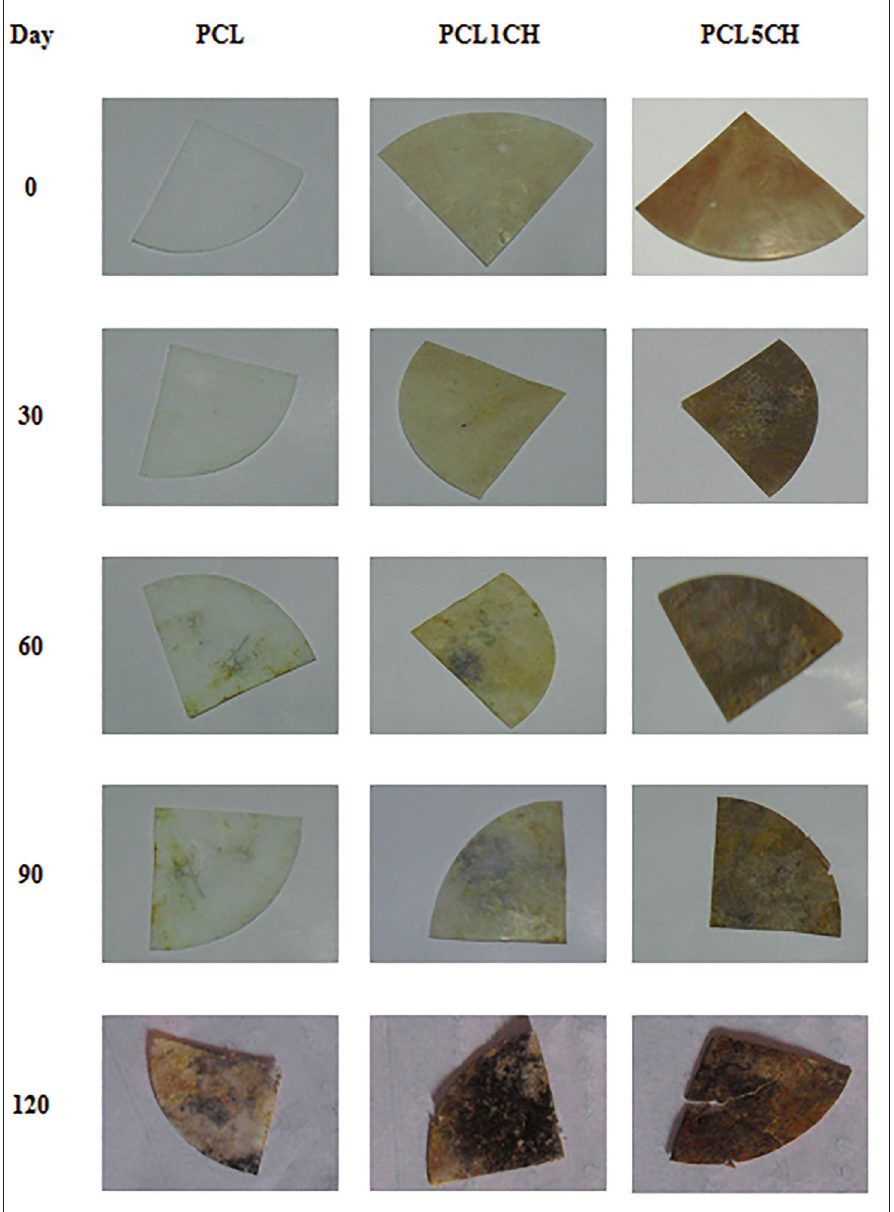
Figure 2: Photographs of PCL, PCL1CH and PCL5CH films during the biodegradation test.